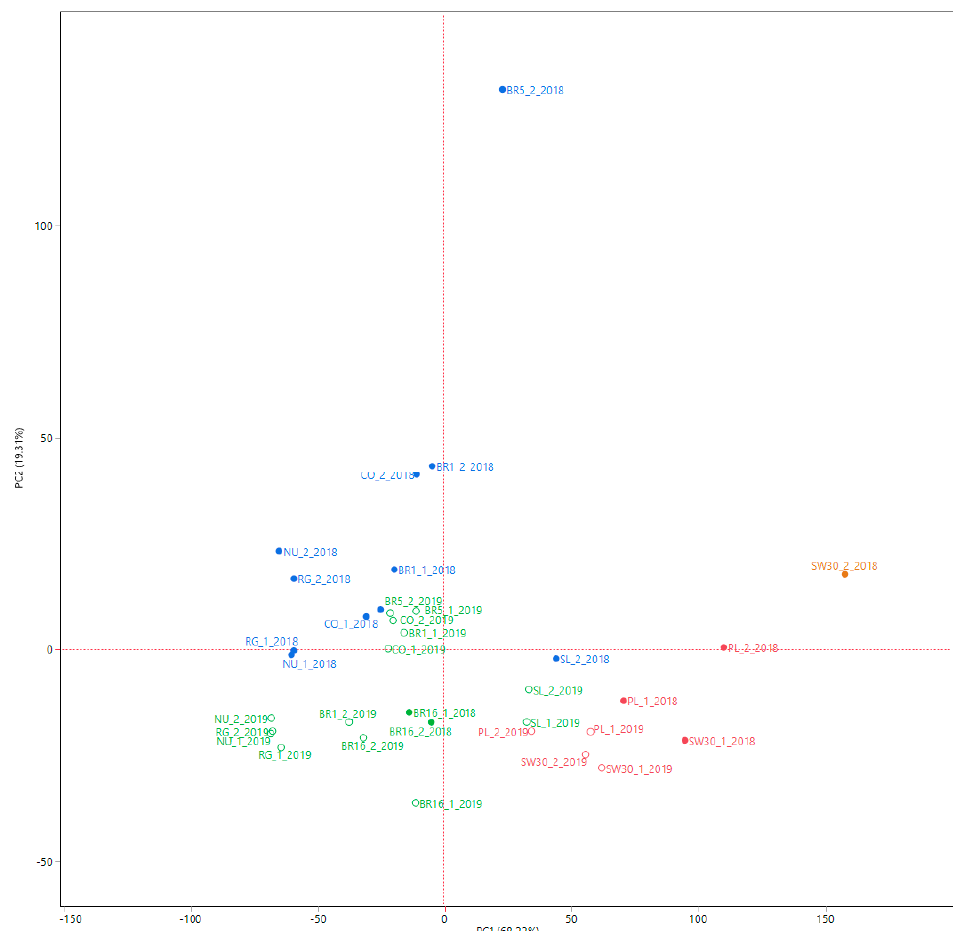
Figure 5. Principal component analysis (PCA) on SVglys profile (Rub, Dulc A, Stev, Reb A, C, D, E and M). Each genotype is followed by the indication of harvest time (1 = first harvest; 2 = second harvest) and crop age (2018 and 2019).